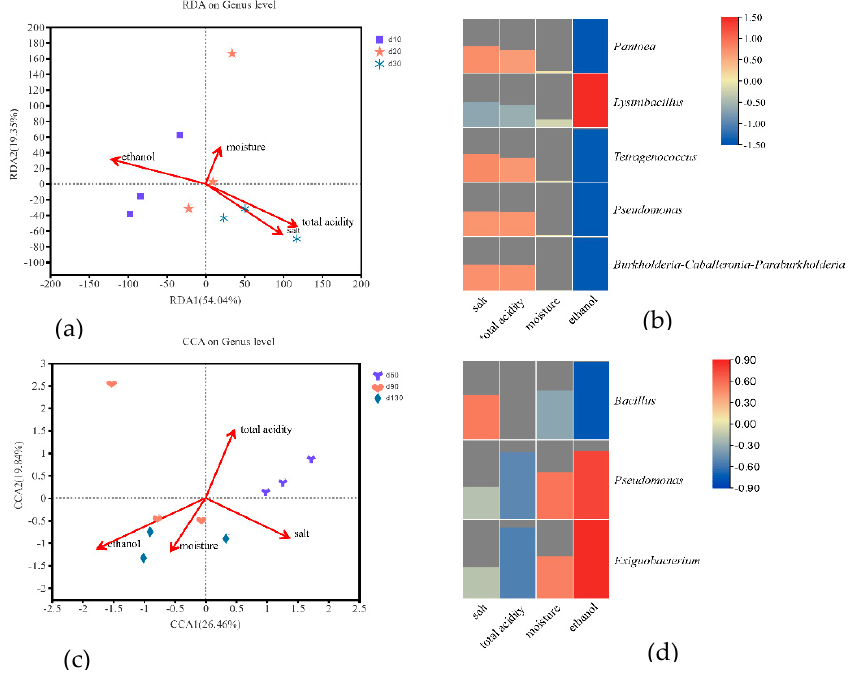
Figure 6. The redundancy analysis for evaluating the distributions of physicochemical factors to bacterial community in the early stage ( a ) and in the late stage ( c ), heatmap analysis of core microbiota with physicochemical factors in the early stage ( b) and in the late stage ( d ), where the peak height represents the magnitude of the correlation.